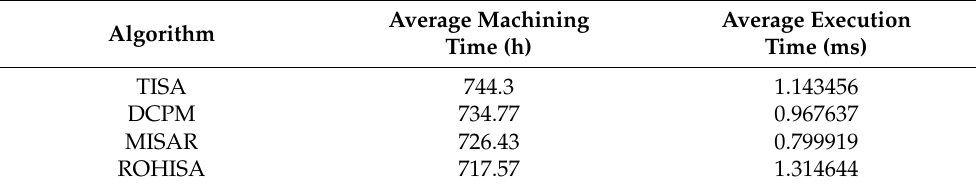
Figure 11. Comparison of the execution time to schedule 100 trees by the four algorithms. Table 1. Average machining time and execution time to schedule 100 trees by the four algorithms.